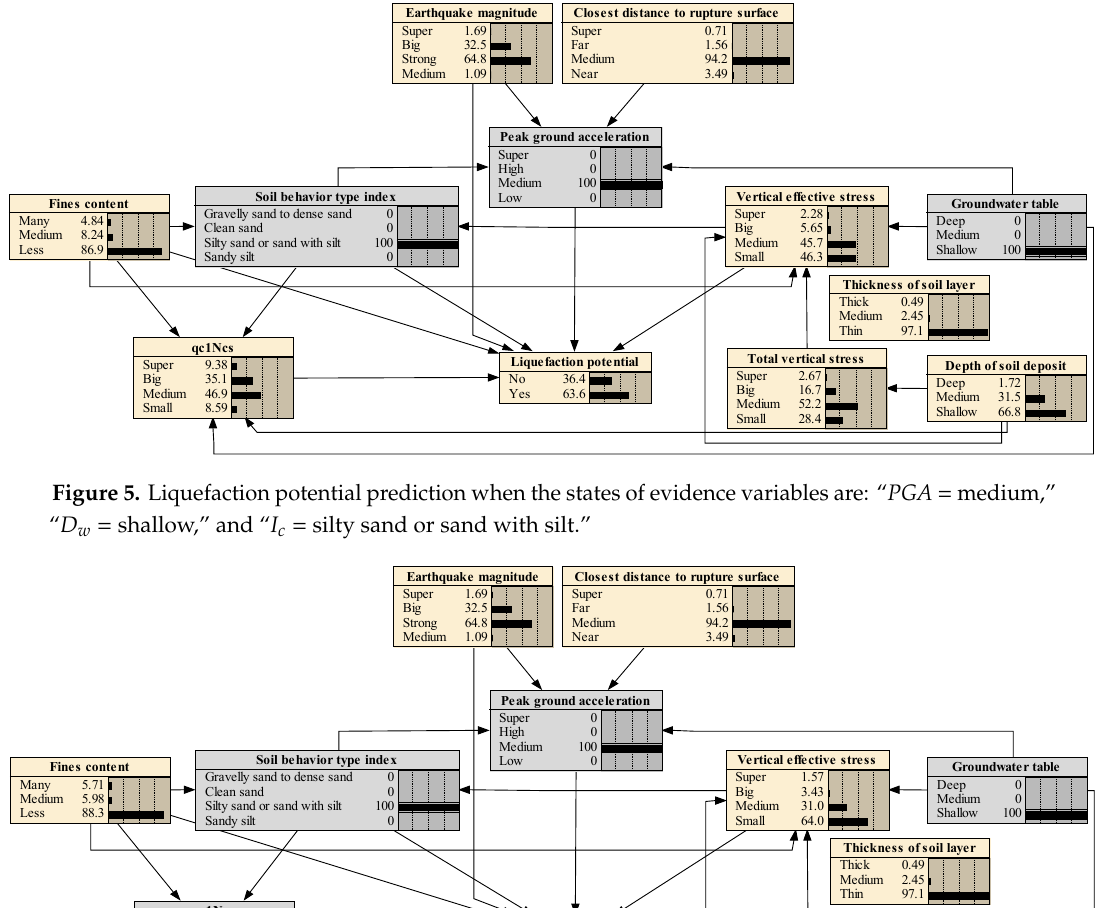
Figure 5. Liquefaction potential prediction when the states of evidence variables are: “ PGA = medium,” “ D w = shallow,” and “ I c = silty sand or sand with silt.”